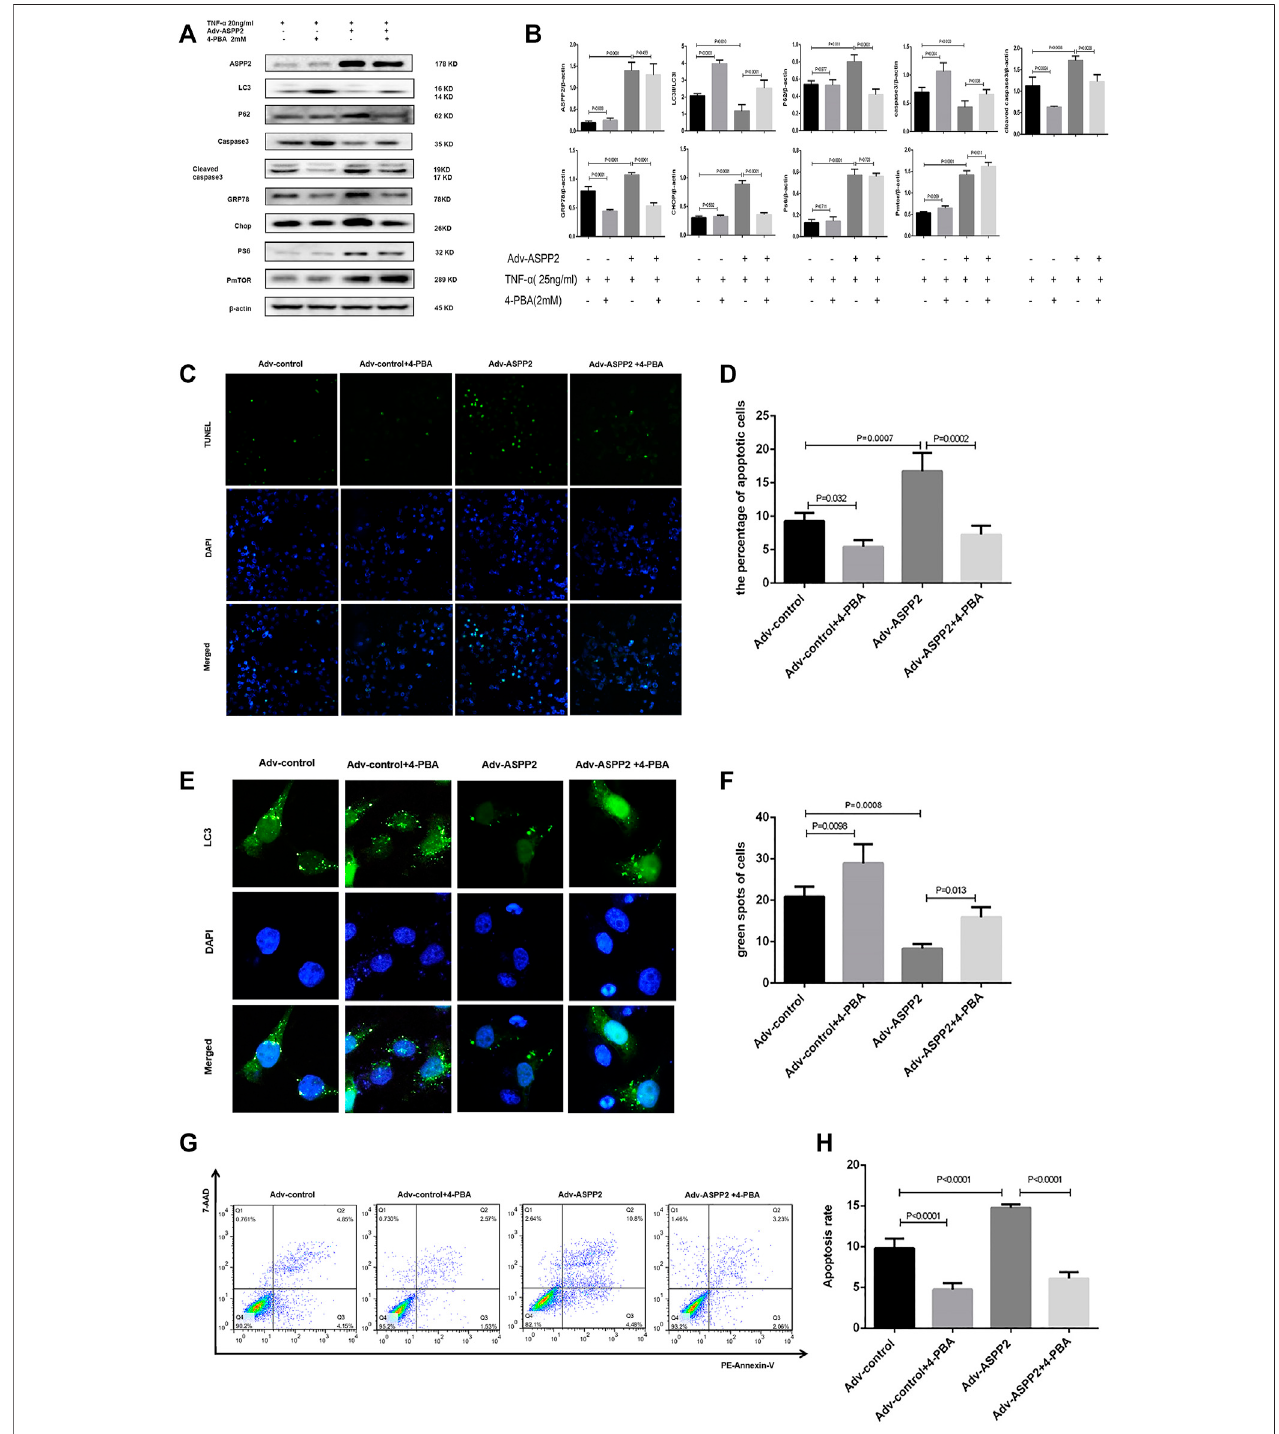
FIGURE 5 | ERS inhibition suppressed ASPP2 mediated-apoptosis, but enhanced autophagic fl ux in case of hepatocyte injury induce by TNF- α . HL7702 cells were transfected by Adv-ASPP2 or Adv-control (5 nM), then pretreated by 4-PBA (2 mM) for 2 h and fi nally induced by TNF- α (25 ng/ml) for 24 h. (A,B) Representative western blotting analysis was conducted of protein expression in HL7702 cells after treatment. Quanti fi cations were normalized to β -actin and expressed as relative density. (C,D) Representative apoptosis images were showed by TUNEL assay. The number of apoptotic cells was counted using ImageJ software. (E,F) A GFP- LC3plasmidwastransfectedintocellsandtherepresentative fl uorescenceimageofcellswasshowed.Thegreenspotsofcellsweremanuallyquanti fi edin fi verandomly selected areas. (G,H) Representative apoptosis images were presented with PE and 7-AAD reagents by fl ow cytometry. The apoptosis rate was calculated using the proportion of early and late apoptotic cells in total cells.